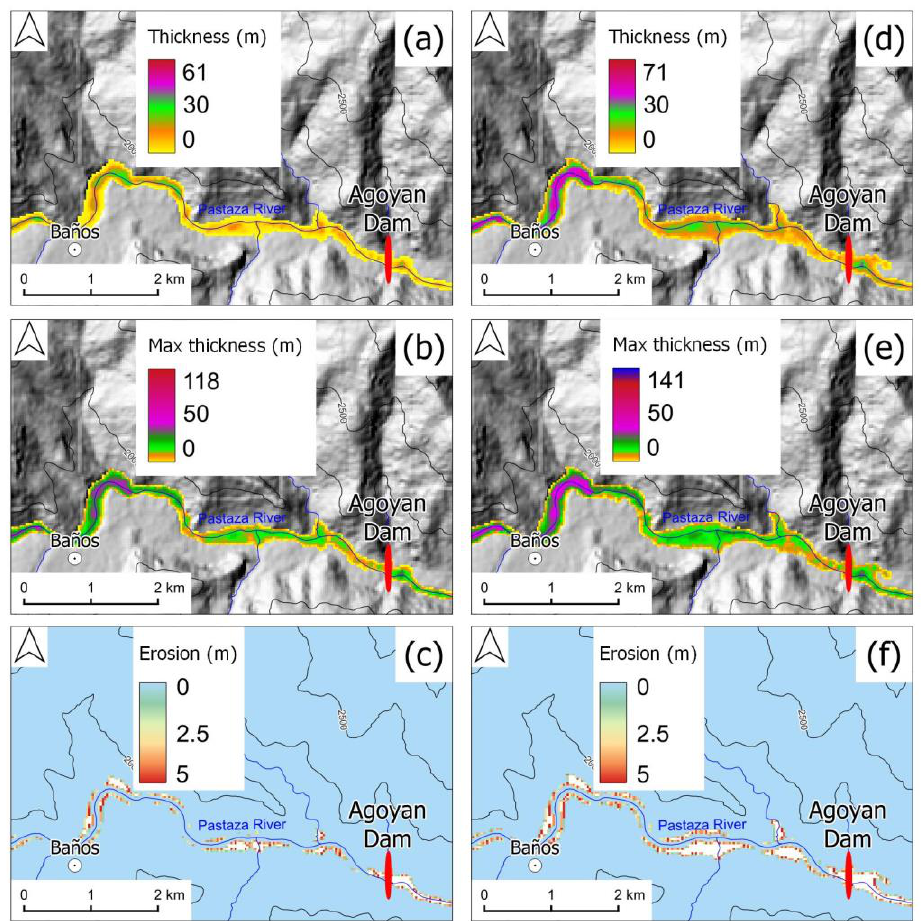
Figure 6. Magnification of the Hidroagoyán Dam area. The lahar observables, as predicted by the simulations, are graphically reported, namely Thickness, Maximum Thickness, and Erosion. Panels ( a – c ) correspond to the S25_125 observables; panels ( d – f ) correspond to the S50_500 observables, respectively.